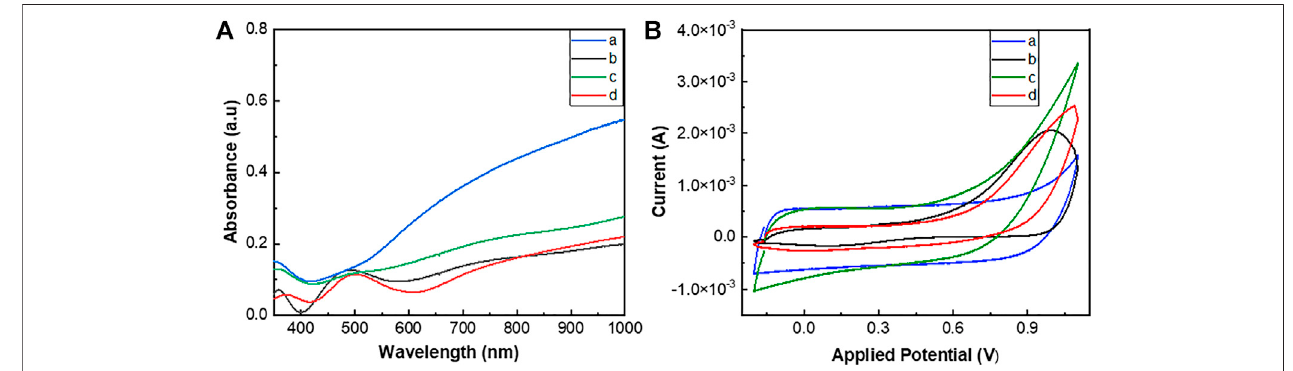
FIGURE2| UV/Visspectra (A) and cyclic voltammograms (B) ofPEDOT (a),poly(EDOTBG) (b), poly(EDOT- co -EDOT-BG) (c),and poly(EDOT-EG4- co -EDOT-BG) (d) fi lmselectrodepositedonITO-glassslides.ThecyclicvoltammogramwasrecordedusingAg/AgClasareferenceelectrodeandPtwireasacounterelectrodeinPBS with 10 mM [Fe(CN)] 3-/4- redox couple at a scan rate of 100